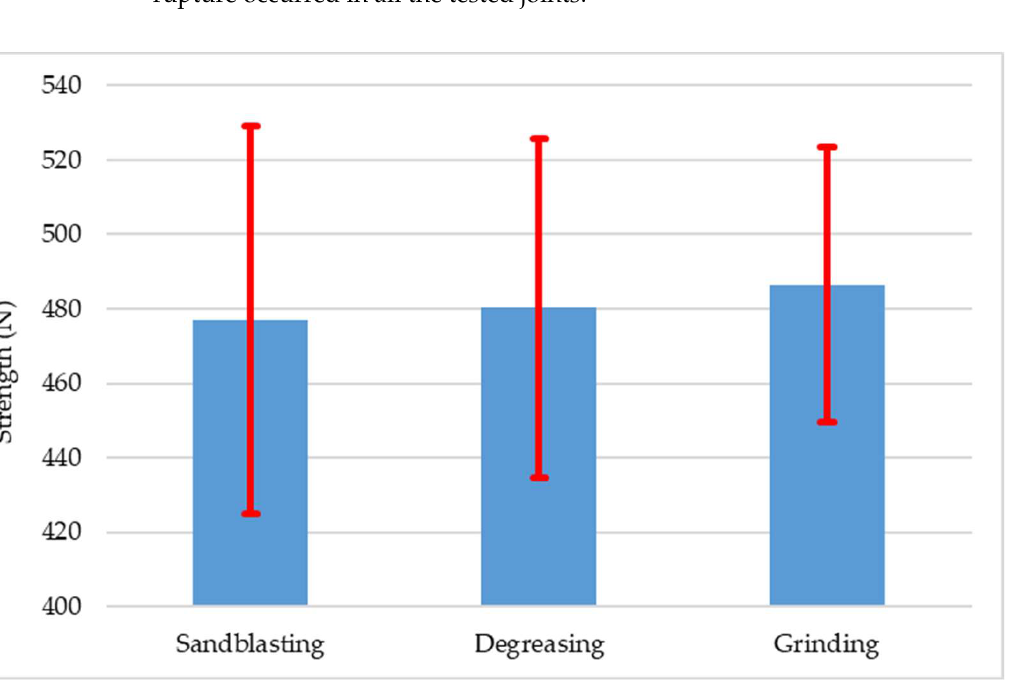
Figure 11. Results of preliminary